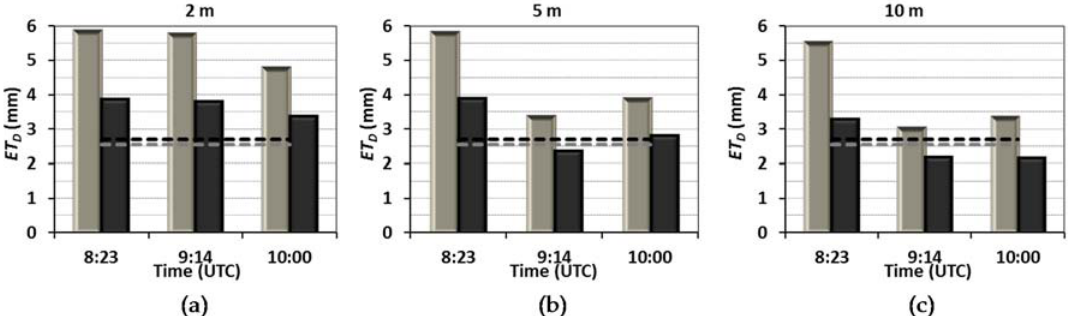
Figure 10. Spatially averaged ET D on the footprint area, calculated using the integration factors based on Λ (grey bars) and R s (black bars), during the image acquisition day for different input spatial resolutions: 2 m ( a ); 5 m ( b ); 10 m ( c ). The dashed lines indicate the ET D measured via the FT (2.7 mm, black line) and the T24 measured via the SF method (2.55 mm, grey line).